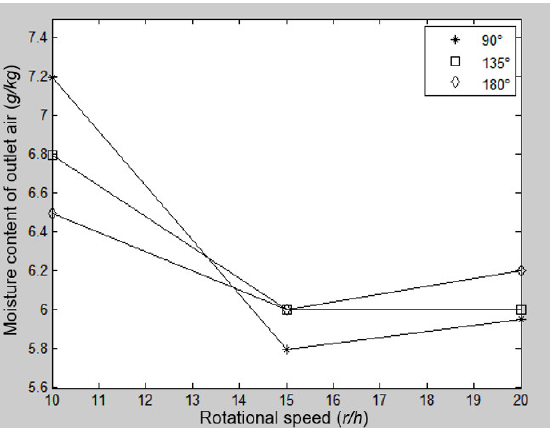
Figure 11. Effect of regeneration angle on adsorption performance (runner thickness: 20 cm).